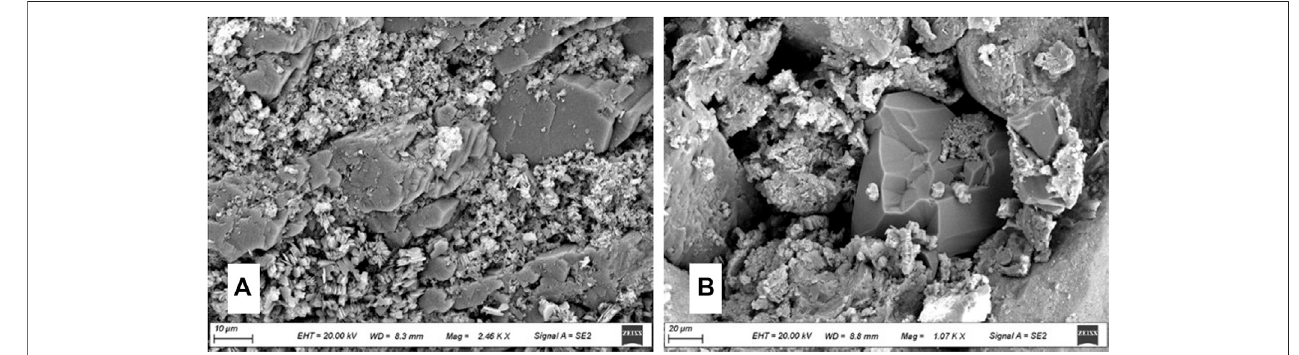
FIGURE 4 | Intergranular pore morphology before ASP fl ooding ( A : surface of particles and pore throats, B : pore throats).